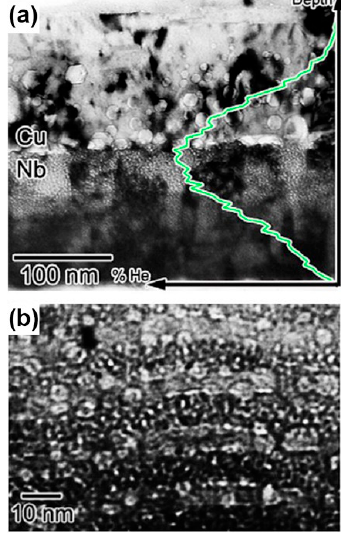
Figure 12. ( a ) Low magnification TEM micrograph of 100 nm Cu/Nb multilayer irradiated with He ions at 150 keV with a dose of 1 × 10 17 ions/cm 2 . ( b ) Defocused HRTEM micrograph of Cu / Nb interfaces indicated cavities in each constituent has 1 nm in diameter and aligned along the interface. ( c ) 2.5 nm Cu / Nb multilayers subjected to He ion irradiation at 150 keV with a dose of 1 × 10 17 ions/cm 2 [7].